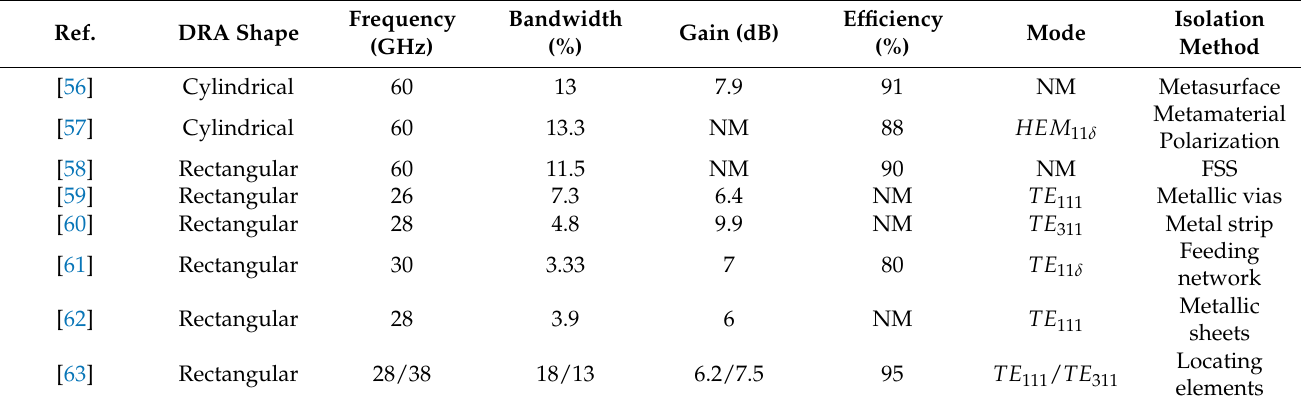
Table 4. Comparison between the performance of MIMO DRAs at V band.